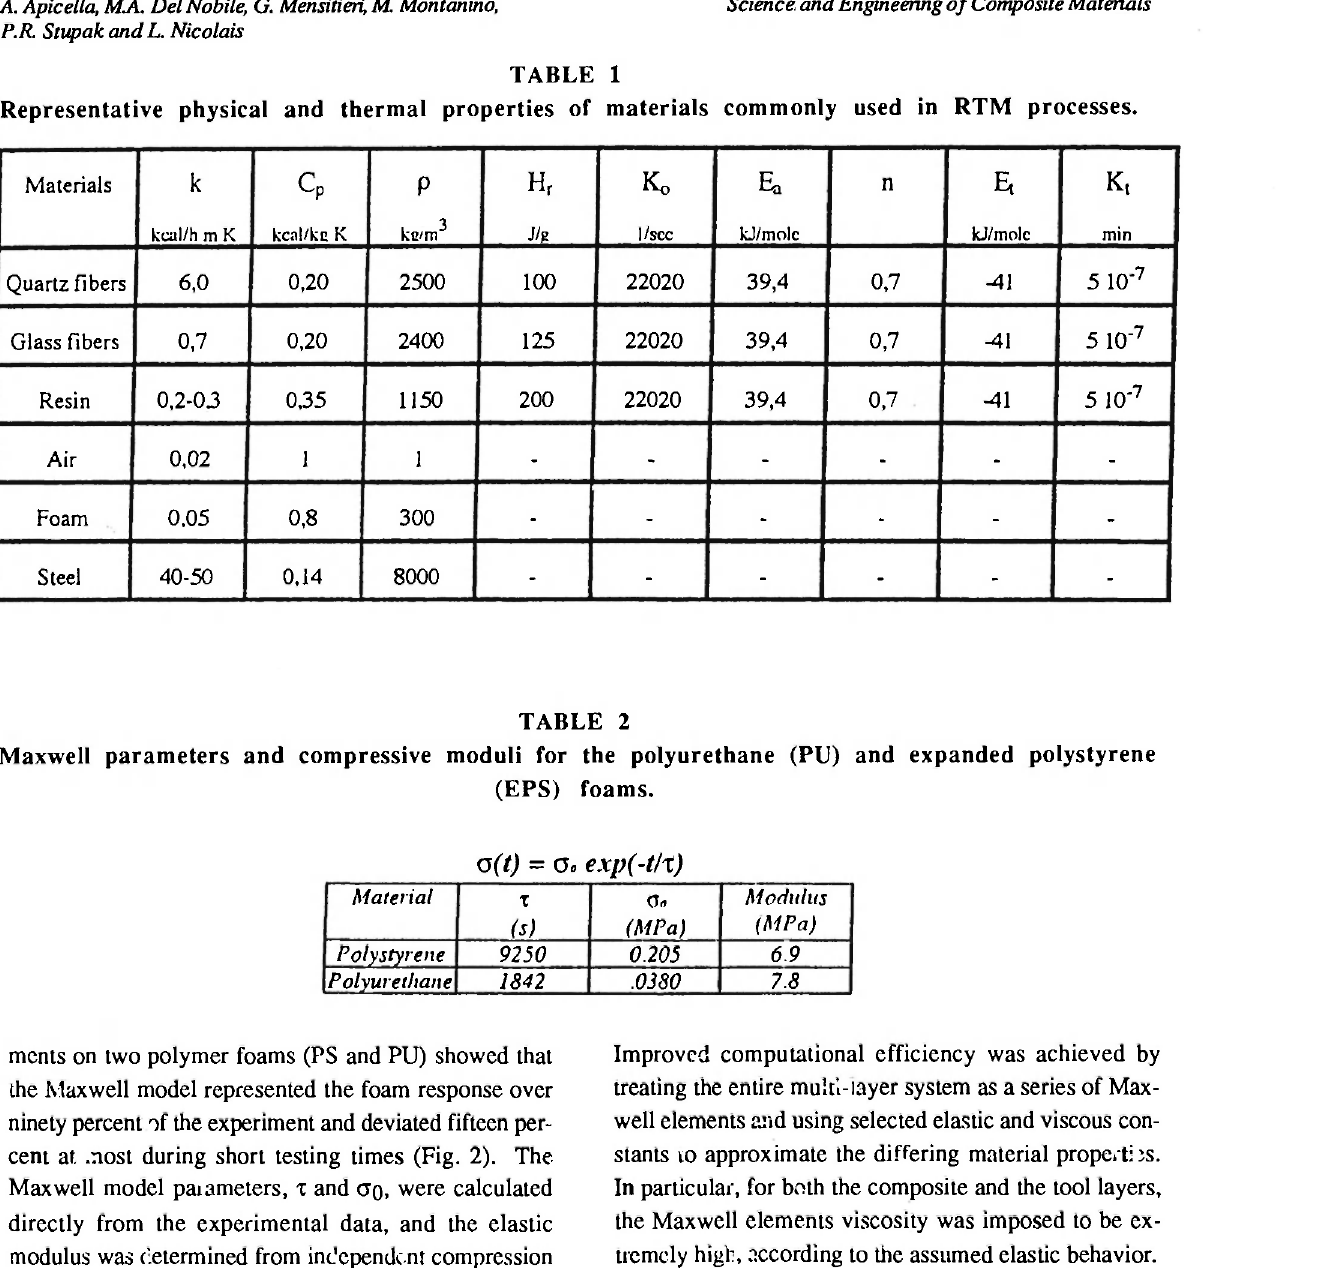
Representative physical and thermal properties of materials commonly used in RTM processes. Materials k